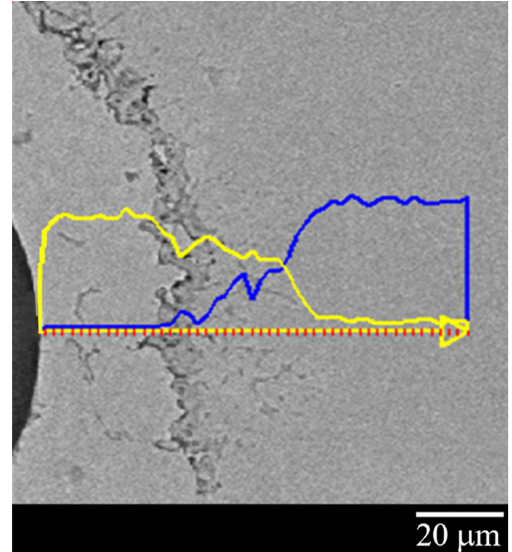
Figure 6. Line analysis of the Cu–Ni ED sample: Cu concentration is plotted in yellow; Ni concentration is plotted in